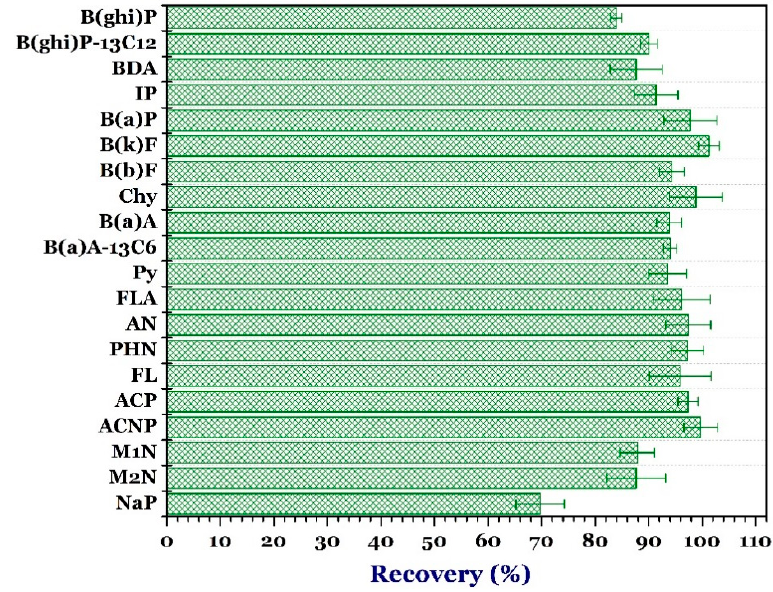
Figure 2. Recovery percentage of 20 compounds of polycyclic aromatic hydrocarbons. Note: naphthalene,